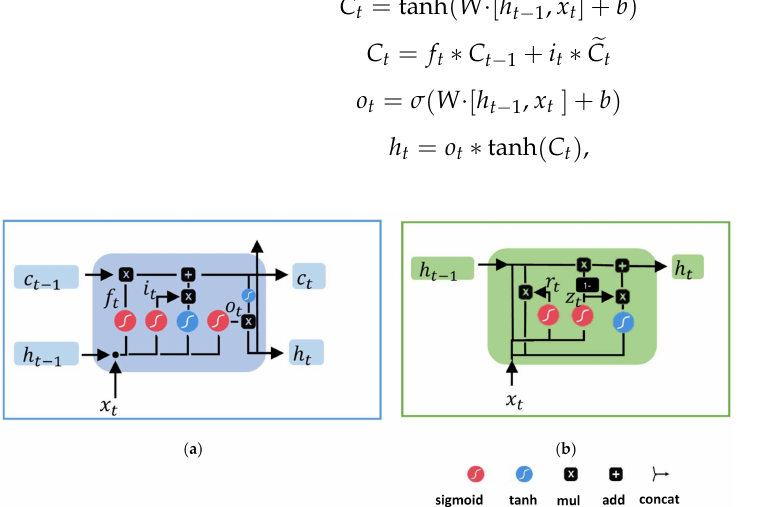
Figure 3. Recurrent units. ( a ) Long short-term memory; ( b ) gate recurrent unit.